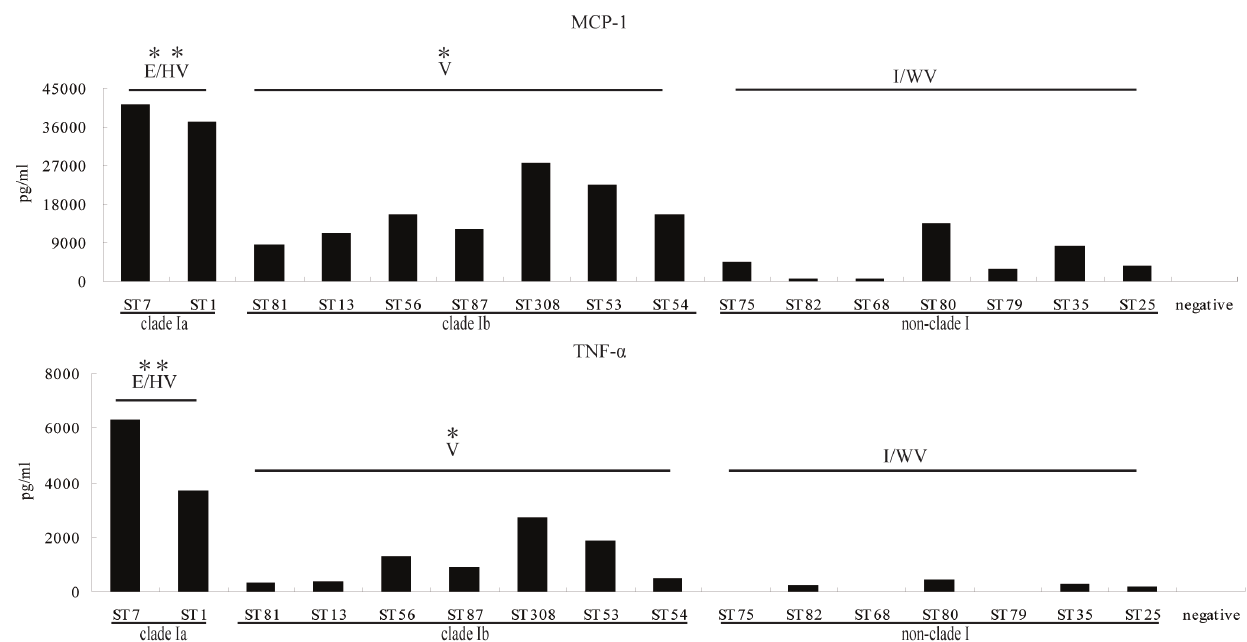
Figure 3. Production of MCP-1 and TNF- a by S.suisinvivo . All data are from two independent experiments. E/HV: epidemic or highly virulent group, V: virulent group, I/WV: intermediately or weakly virulent group. *Significant, P , 0.05, two asterisks (**): the value of group E/HV compared to group V and I/WV. One asterisk (*): the value of group V compared to group I/WV.